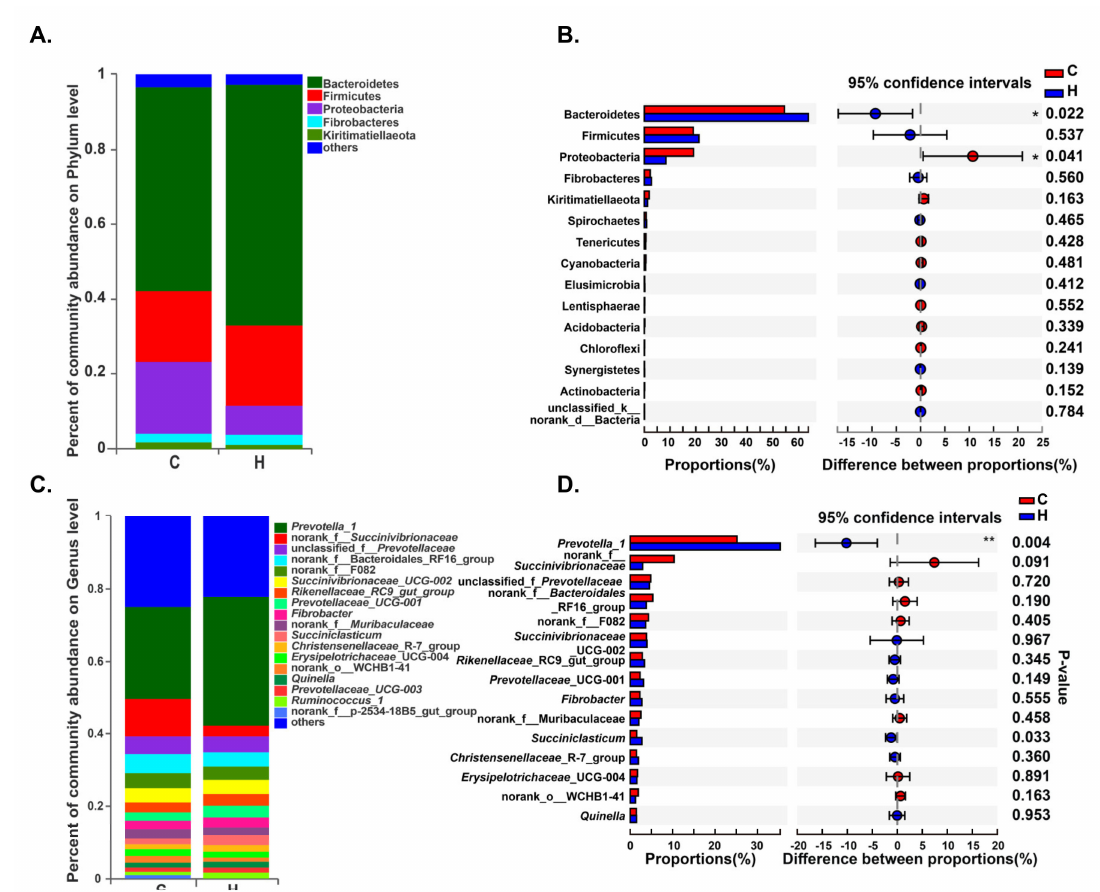
Figure 2. Distribution of bacteria in di ff erent groups. The color-coded bar plots represent the average distribution of bacterial phyla ( A ) and genera ( C ), respectively. Only the dominant bacteria (with a relative abundance ≥ 1%) among rumen bacteria are shown. Extended error bar plots illustrate the mean proportions and di ff erences in the phyla ( B ) or genera ( D ) in rumen samples. * indicates p < 0.05.